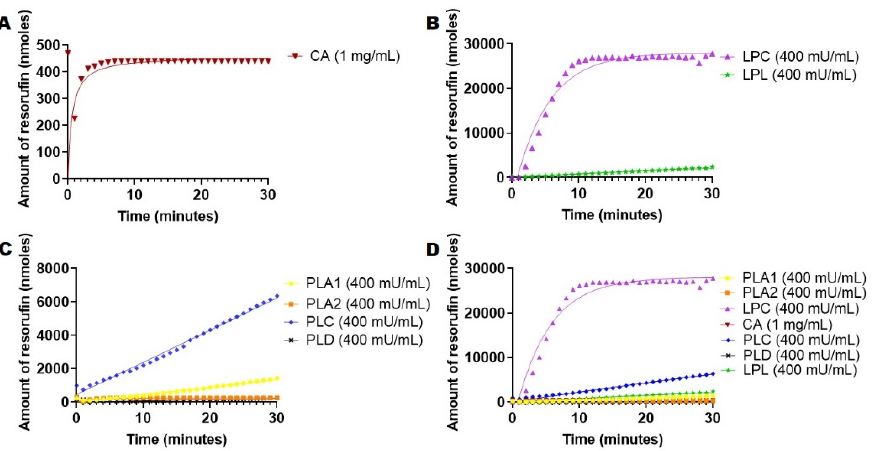
Figure 3. Hydrolysis of DGGR of lipases and esterase (80 U/mL) in 20 mM Tris-HCl, 150 mM NaCl and 0.05% Triton X-100 and 800 µg DGGR. The amount of resorufin produced was determined via absorbance at 572 nm. ( A ) Hydrolysis with CA. ( B ) Hydrolysis with lipases (LPC and LPL). ( C ) Hydrolysis with Phospholipases (A1, A2, C and D). ( D ) All hydrolysis kinetics (esterases and lipases) combined.